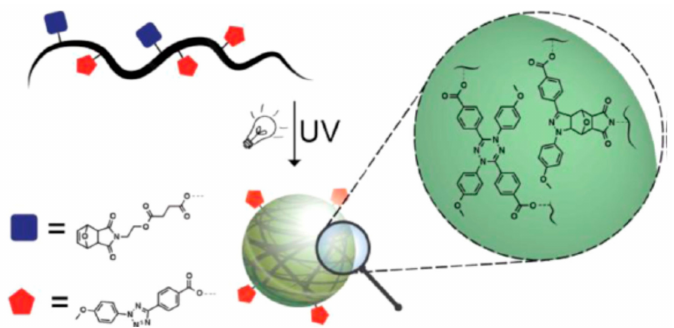
Figure 14. SCNP formation via photoinduced NITEC using polymers containing protected maleimide (in blue color ) and tetrazole (in red color ) moieties. In addition to the NITEC heterocoupling reaction, the nitrile imine self-dimerization from tetrazole units (homocoupling reaction) takes place as a secondary reaction. Reprinted from [48] with